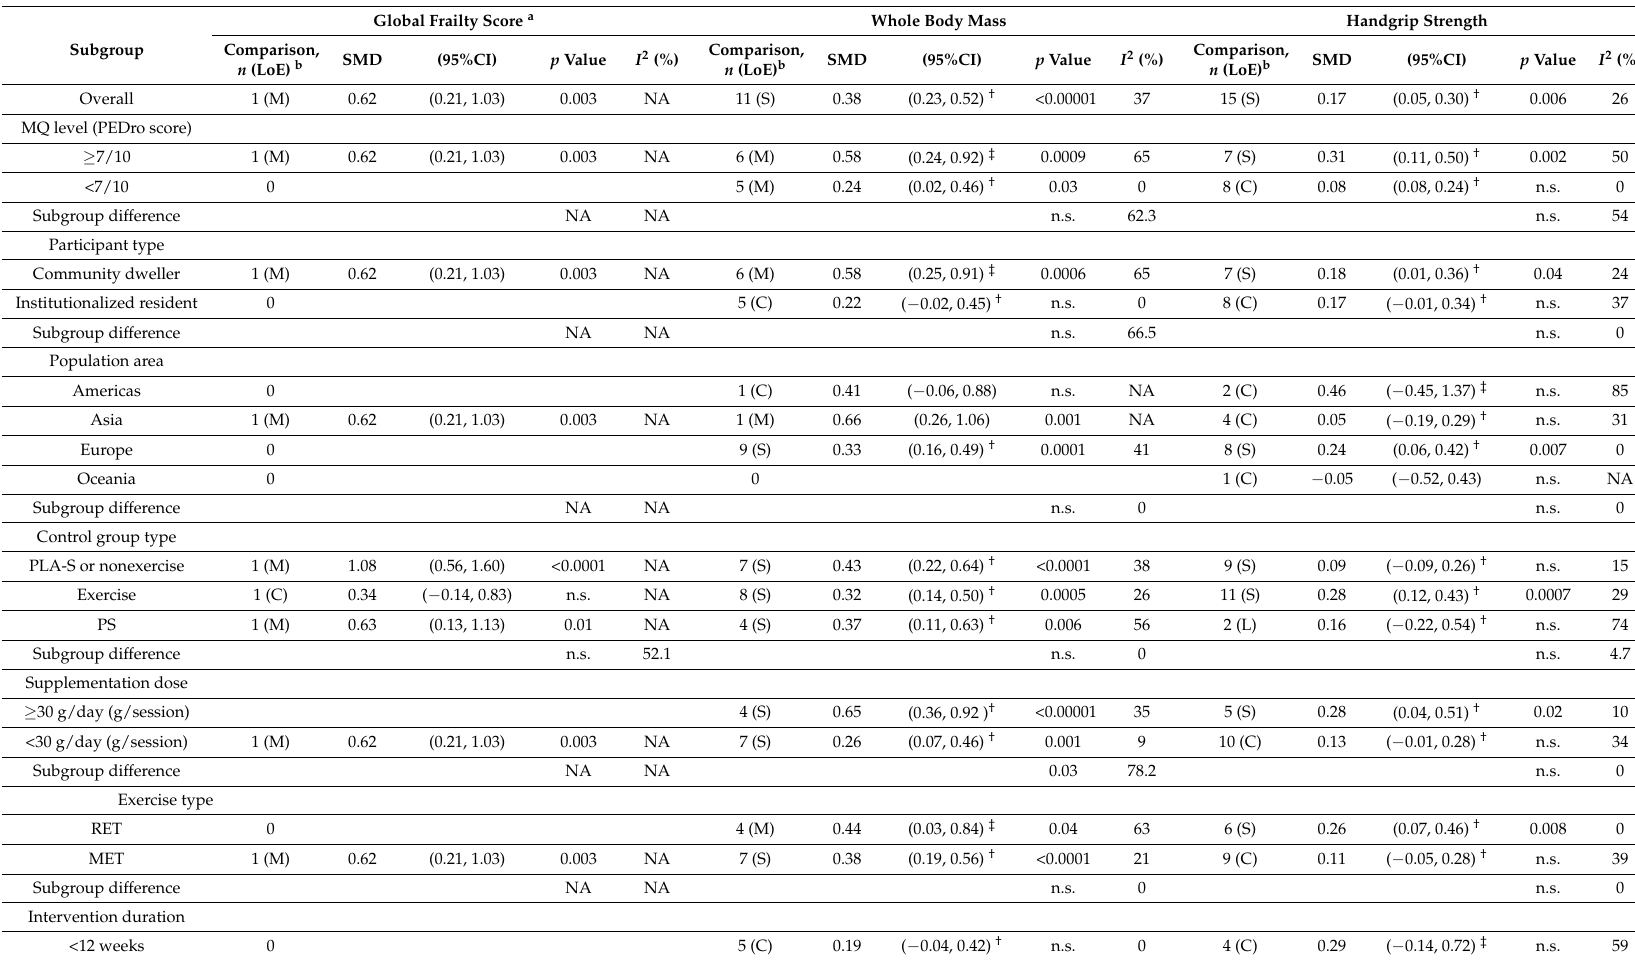
Table 3. Summary of overall effects and subgroup analysis results for frailty